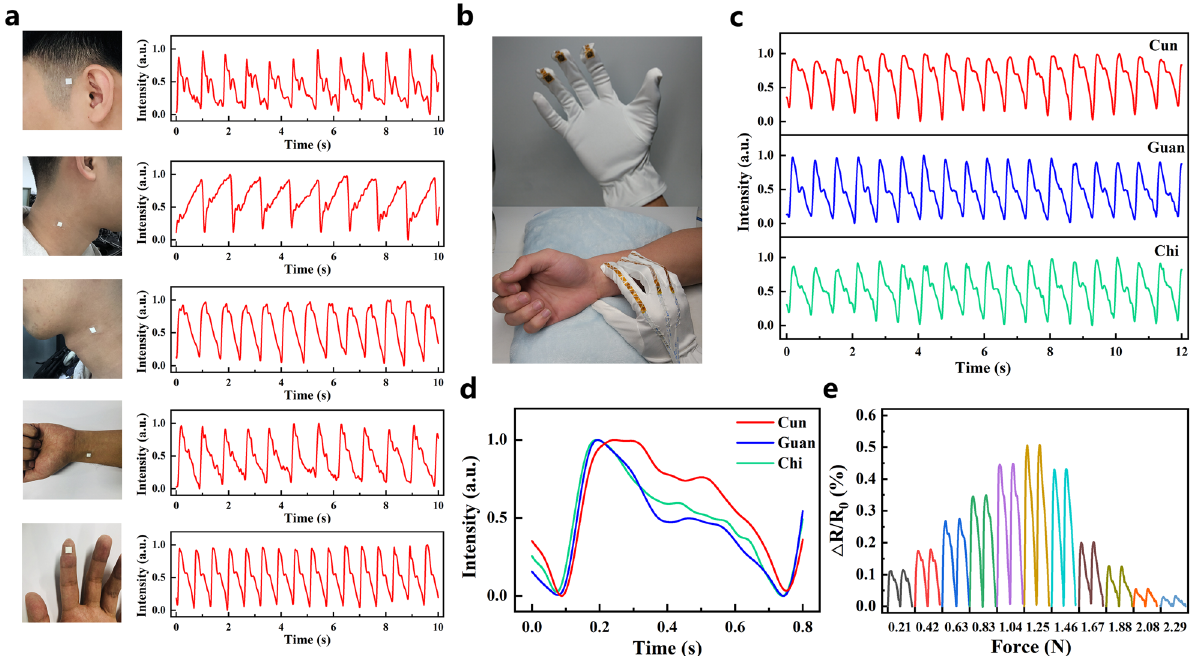
Fig. 2 Flexible sensors for recording the pulse waves from different acupoints in the body. a Typical pulse waves from fi ve acupoints: left super fi cial temporal artery, right jugular artery, left carotid artery, radial artery, and fi ngertip artery. b A glove equipped with three fl exible sensors to simultaneously acquire the pulse wave from three acupoints of traditional Chinese medicine: Cun, Guan, and Chi. c Pulse wave from three acupoints of Cun, Guan, and Chi. d Comparison of pulse waves within a single period. e Pulse waves from Guan acupoint obtained under the different pressure